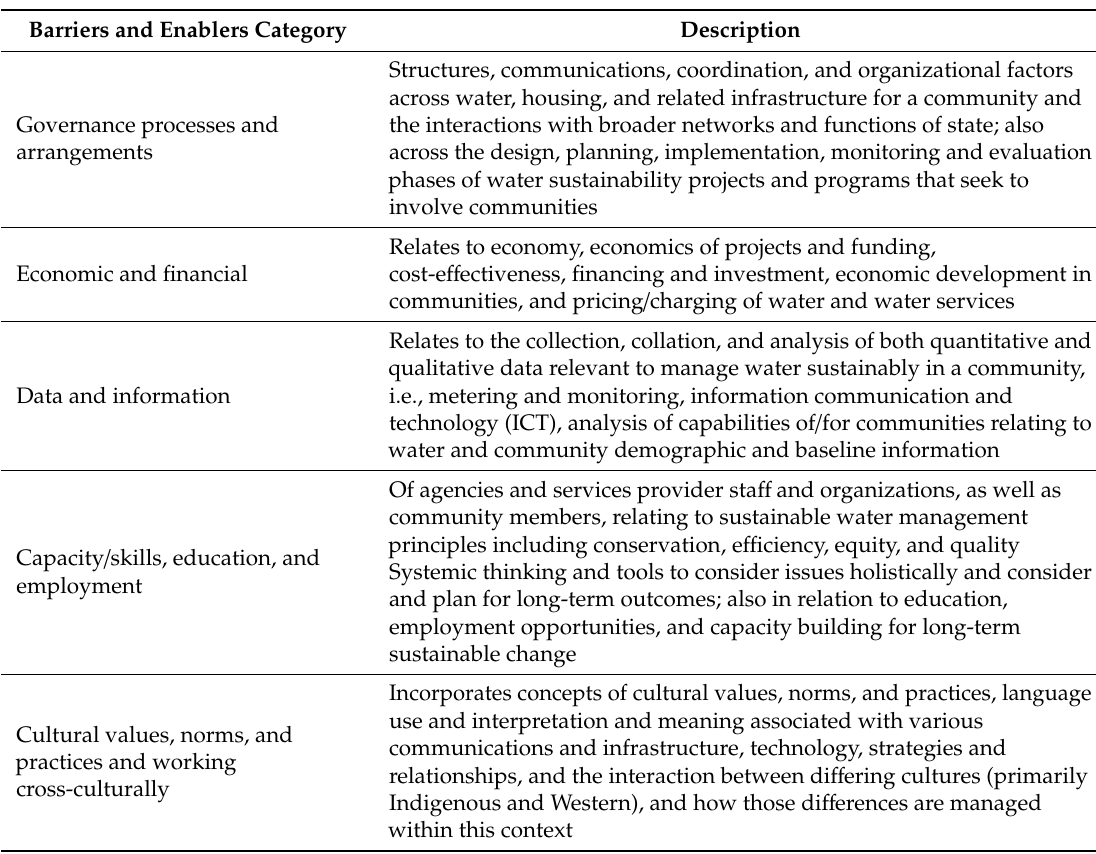
Table A2. Barrier and enabler category